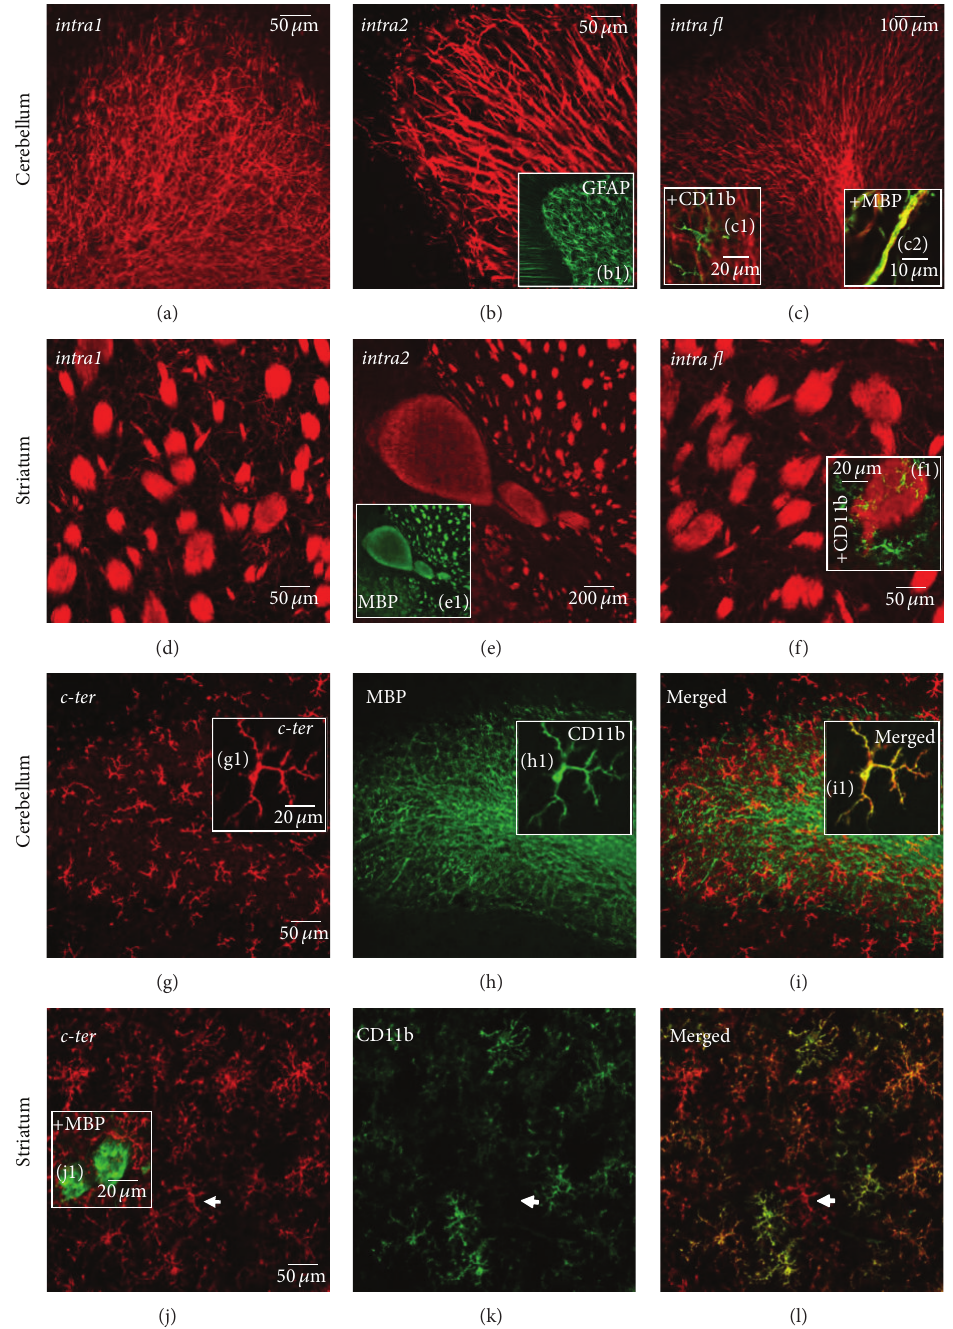
Figure 3: P2Y 12 receptor in rat brain tissue. Double immunofluorescence and confocal analysis was performed on sections from rat cerebellum (panels (a), (b), (c), (g), (h), and (i)) and striatum (panels (d), (e), (f), (j), (k), and (l)) with intra1 , intra2 -lots AN01/02/04, intra fl , c-ter (all red), and GFAP (green, inset b1), CD11b (green, insets c1, f1, h1; yellow merged, inset i1; green, panel (k); merged, panel (l)), MBP (yellow merged, inset c2; green, inset e1; green, panels (h) and (i); green, inset j1)